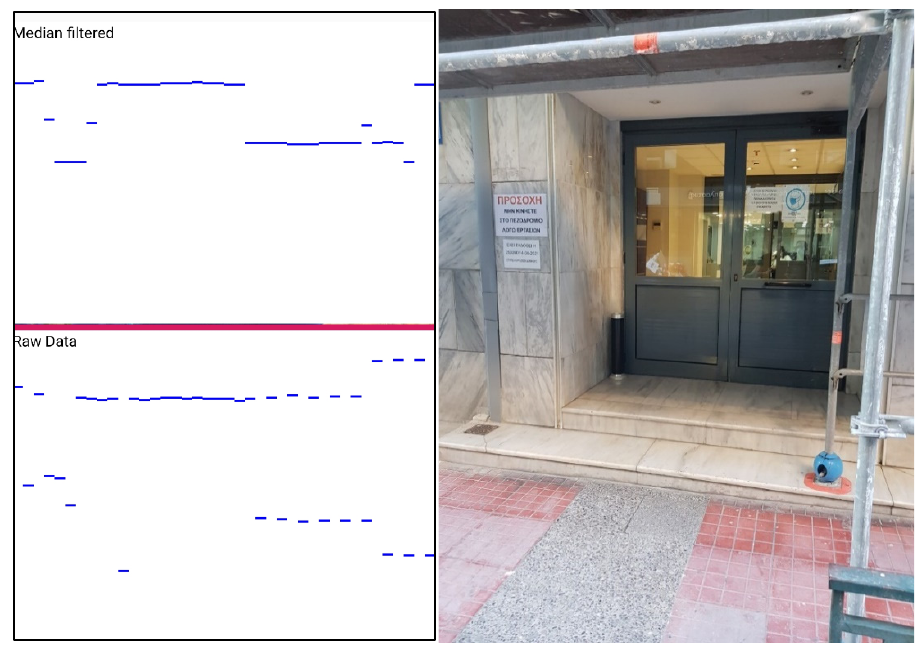
Figure 24. Response of sonar obstacle detection